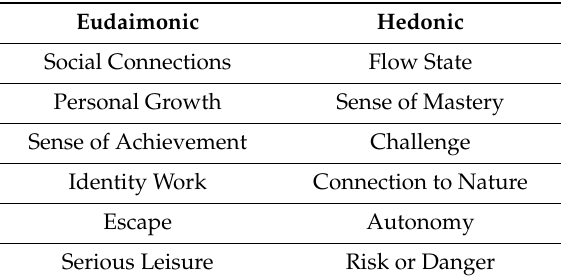
Table 3. Qualitative theme